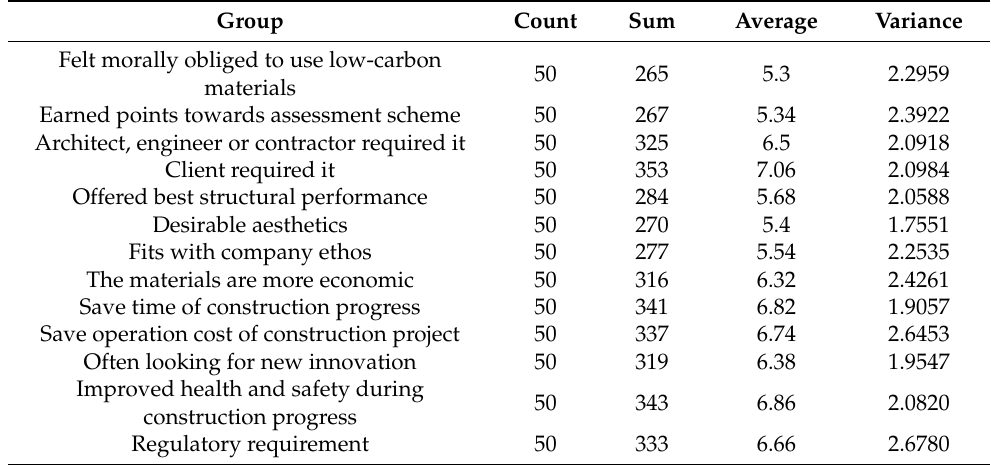
Table 8. One-way ANOVA of the current factors encouraging the use of alternative materials.